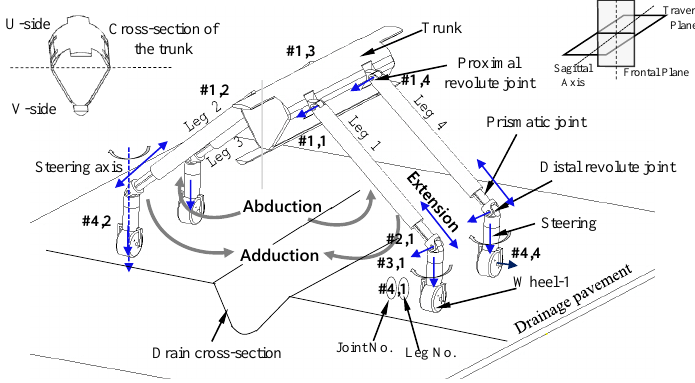
Figure 2. Line diagram of the Tarantula on the drainage